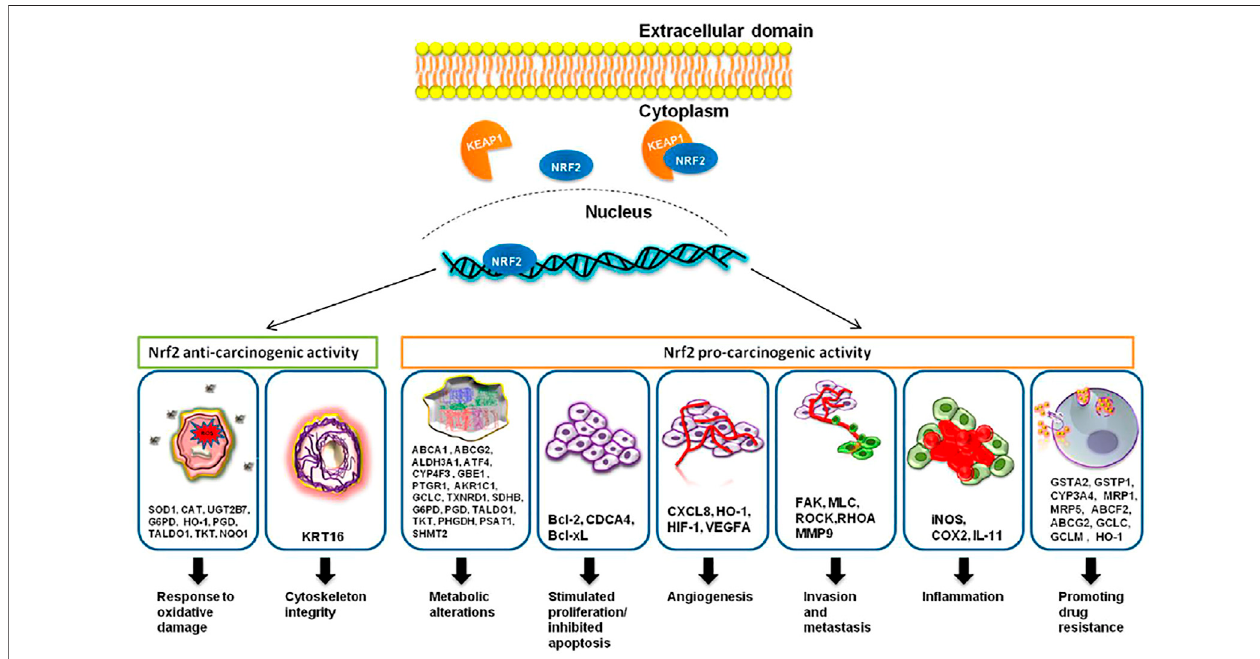
FIGURE 1 | Nrf2, through its targeted genes, has an anti-carcinogenic role in the case of normal cells and a pro-carcinogenic effect in the case of transformed malignant cells. The image was acquired from (Zimta et al., 2019). Under creativecommons.org/licenses/by/4.0/.